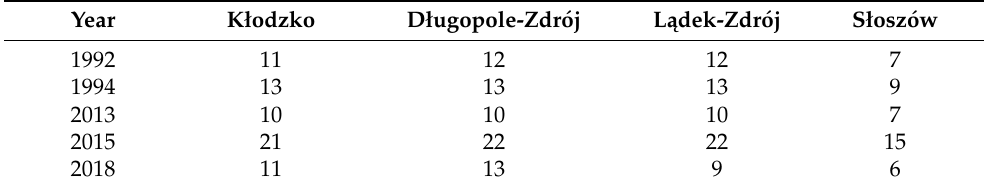
Table 5. Annual frequency of heat days in the most extreme years in 1971–2020 in Kłodzko Land.